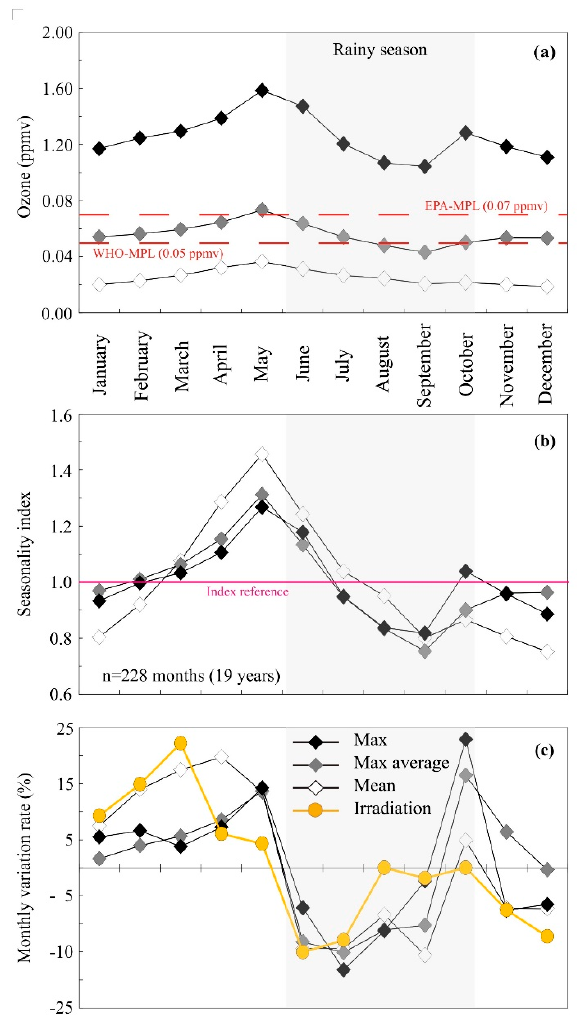
Figure 5. ( a ) Monthly ozone values regarding the maximum permissible limits of EPA standards and WHO guidelines, ( b ) Monthly ozone variation is based on the decomposition of the seasonal subseries and index of seasonality, and ( c ) comparison of the monthly variation between ozone concentrations and solar irradiation.